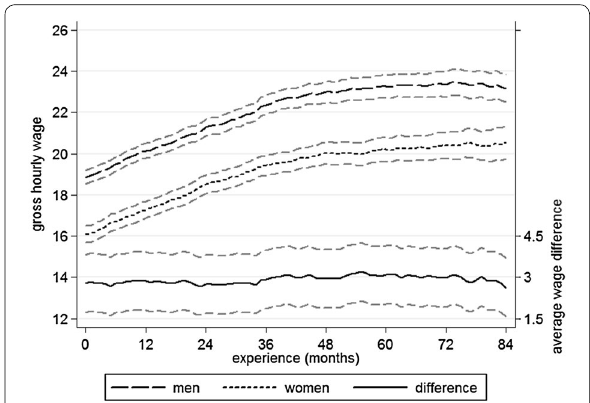
Fig. 2 Changes in pay by gender: gross hourly wages with 95% CIs ( Source BAP 2005/06, author’s calculations; performed with Stata13)